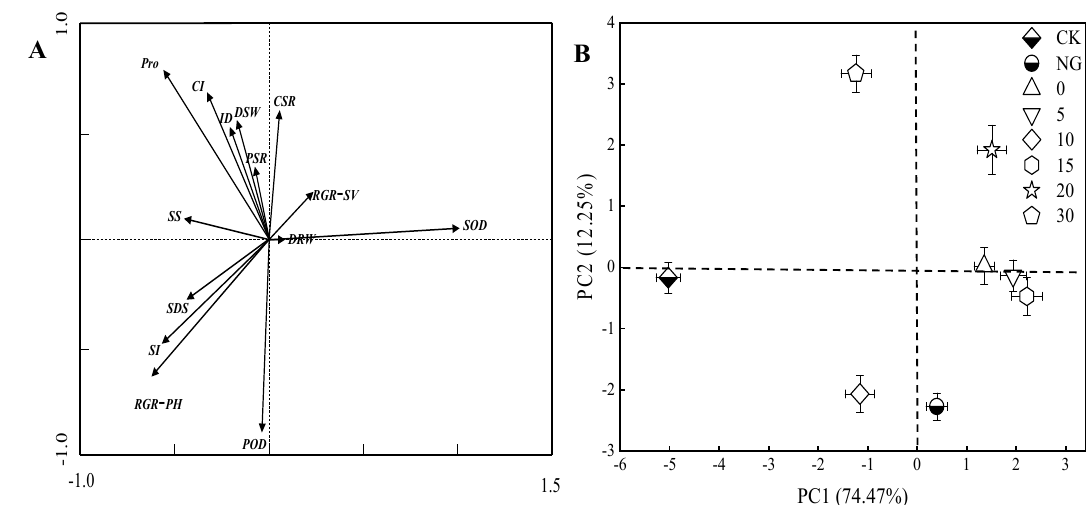
Figure 5. Principal component analysis of osmotic adjustment substance and enzyme activity-related parameters, ion distribution-related parameters, and plant growth characteristics. Arrow direction and length indicate correlation and strength, respectively. Bars represent standard errors. ID, injury degree; POD, peroxidase; SOD, superoxide dismutase; Pro, proline; SS, soluble sugar; SI, sodium ion content of cucumber leaf; CI, calcium ion content of cucumber leaf; SDS, salt damage score; DSW, dry shoot weight; DRW, dry root weight; PSR, potassium and sodium ratio of leaf; CSR, calcium and sodium ratio of leaf; RGH-PH, relative growth rate of plant height relative growth rate; RGH-SV, relative growth rate of stem volume.